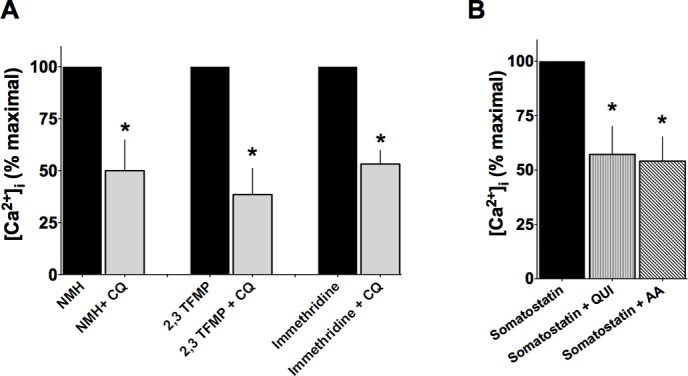
TAS2R inhibition of stimulated [Ca2+]i is not dependent on Gi or Gq coupled receptor stimulation.(A) HASM were co-treated with Gq-coupled HRH1 agonists NMH or 2,3 TFMP, or the Gi-coupled HRH3 agonist immethridine and 50 μM CQ. (B) Somatostatin (Gi-coupled) stimulated [Ca2+]i is inhibited by QUI and AA. *, P<0.05, N = 4 experiments.